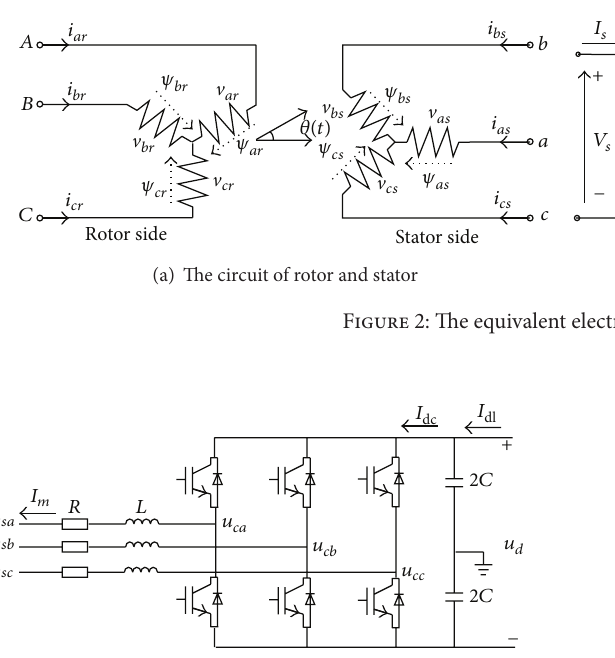
Figure 3: Converter circuit diagram.